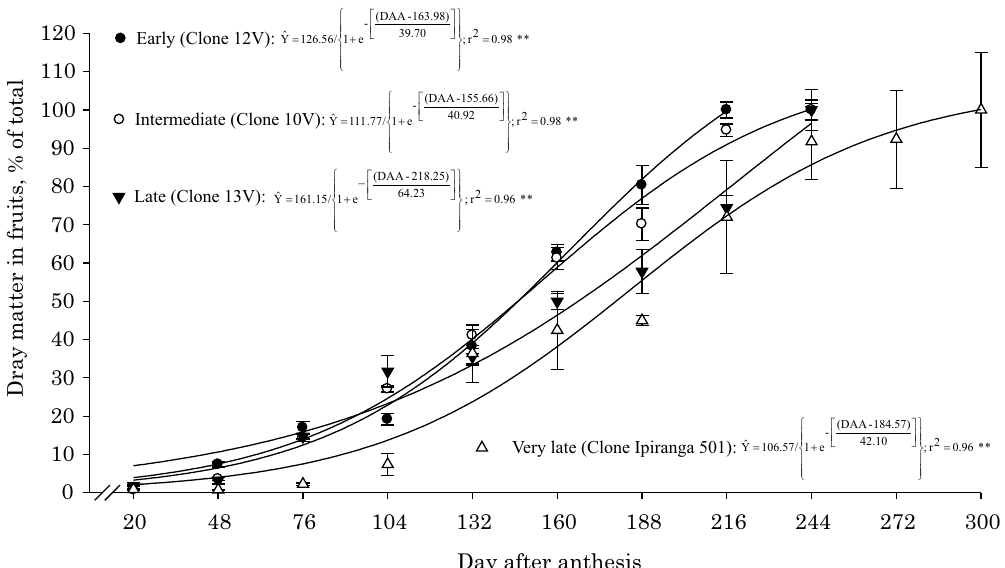
Figure 1. Dry matter accumulation in fruits (as a percentage of the cumulative total) of four genotypes (clones) of Conilon coffee, from anthesis to fruit maturation. The bars refer to the standard error of the average. ** significant at 1 % probability.